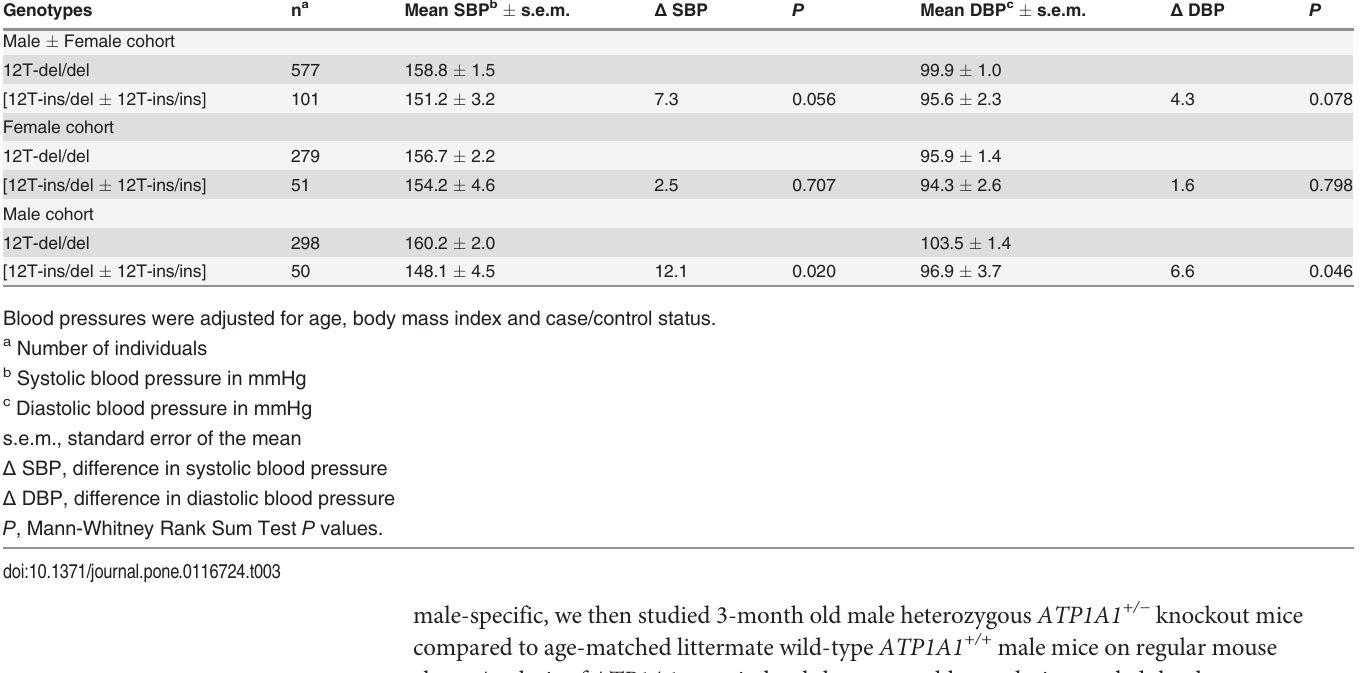
Table 3. Analysis of ATP1A1 (12T-ins/del) variants based on blood pressure as a quantitative trait. Genotypes n a Mean SBP b (cid:3) s.e.m.